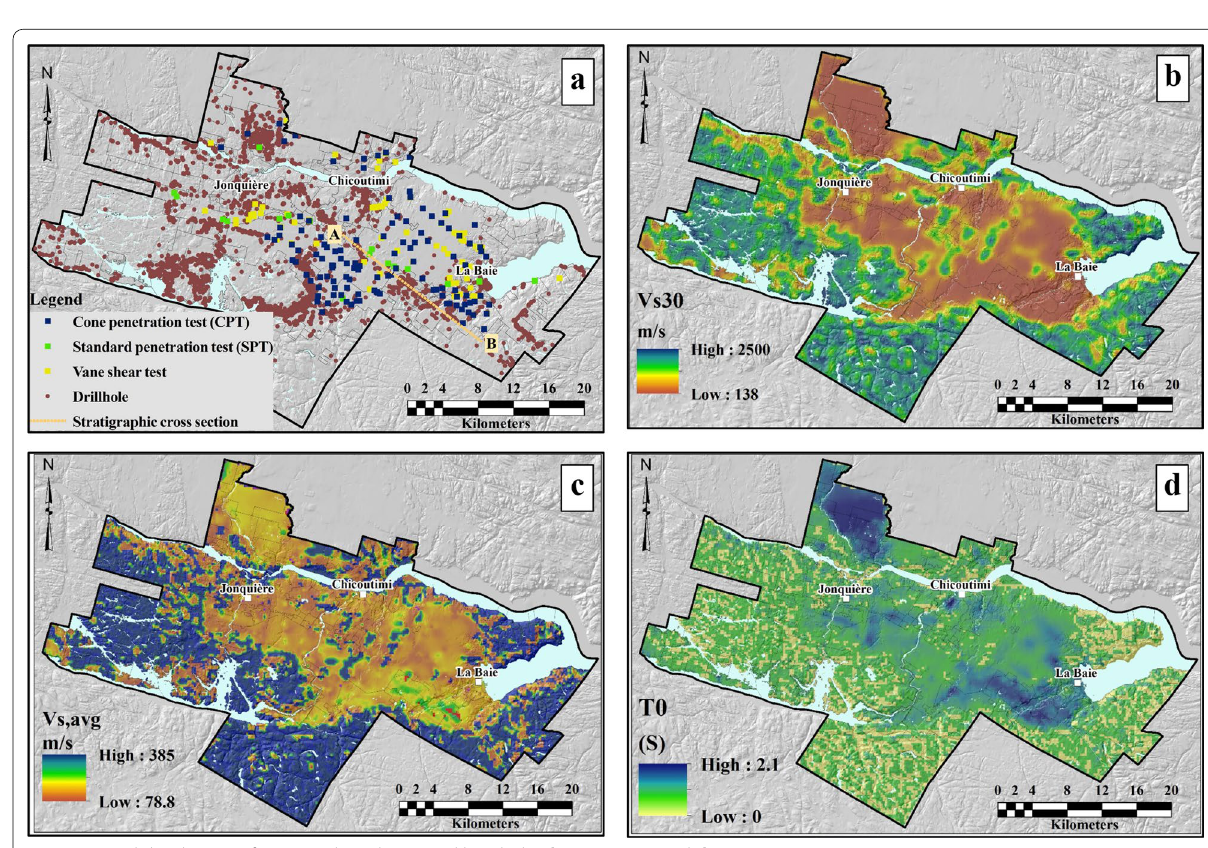
Fig. 3 Spatial distribution of: a geotechnical tests and boreholes, b V s ,30 , c V s , avg and d T